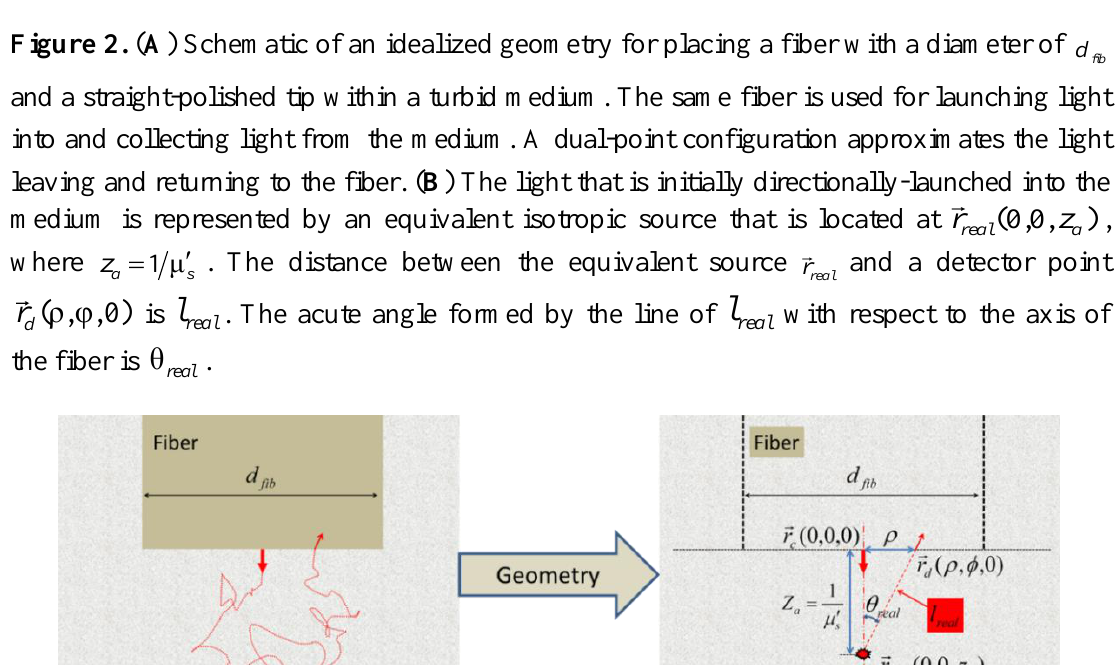
d fib  zr , areal and a detector point l with respect to the axis of real